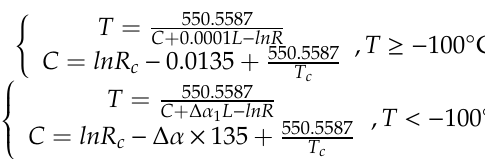
Figure 8. The composition and material of the optical fiber.